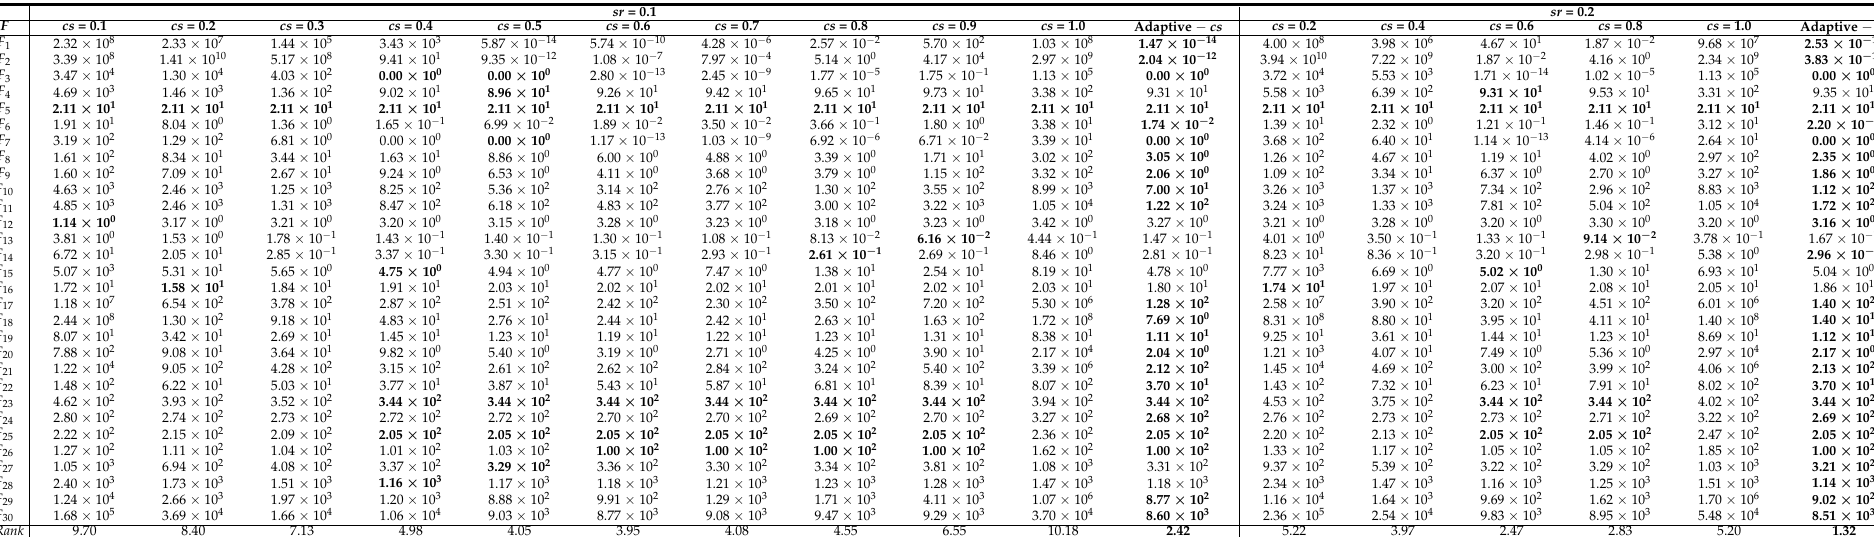
Table 6. Comparison between ACSEDA, with and without the adaptive covariance scaling method, on the 50- D CEC 2014 benchmark problems. The best results in each part are highlighted in bold in this table. sr =0.1 sr =0.2 F cs